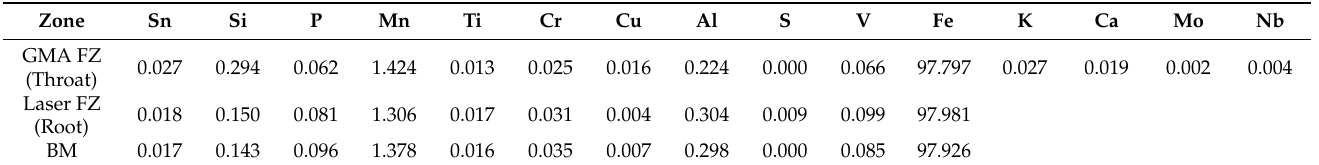
Figure 10. Interest areas of the welded sample where X-ray fluorescence analysis took place. Table 5. Chemical composition measured as weight percent (weight %) by X-ray fluorescence